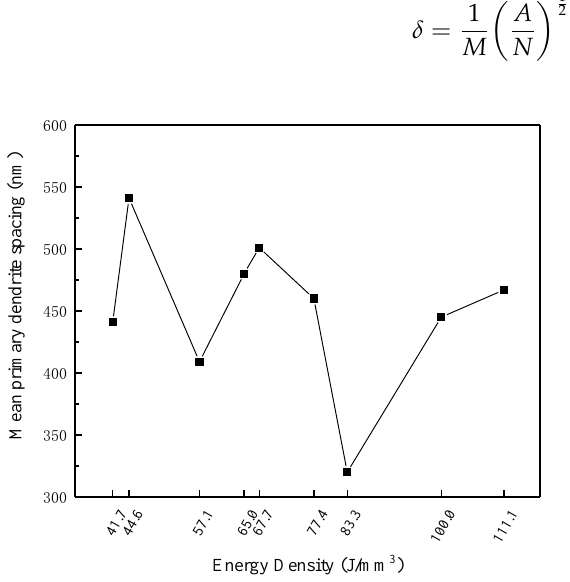
Figure 9. Effect of energy densities on the primary dendrite spacing.